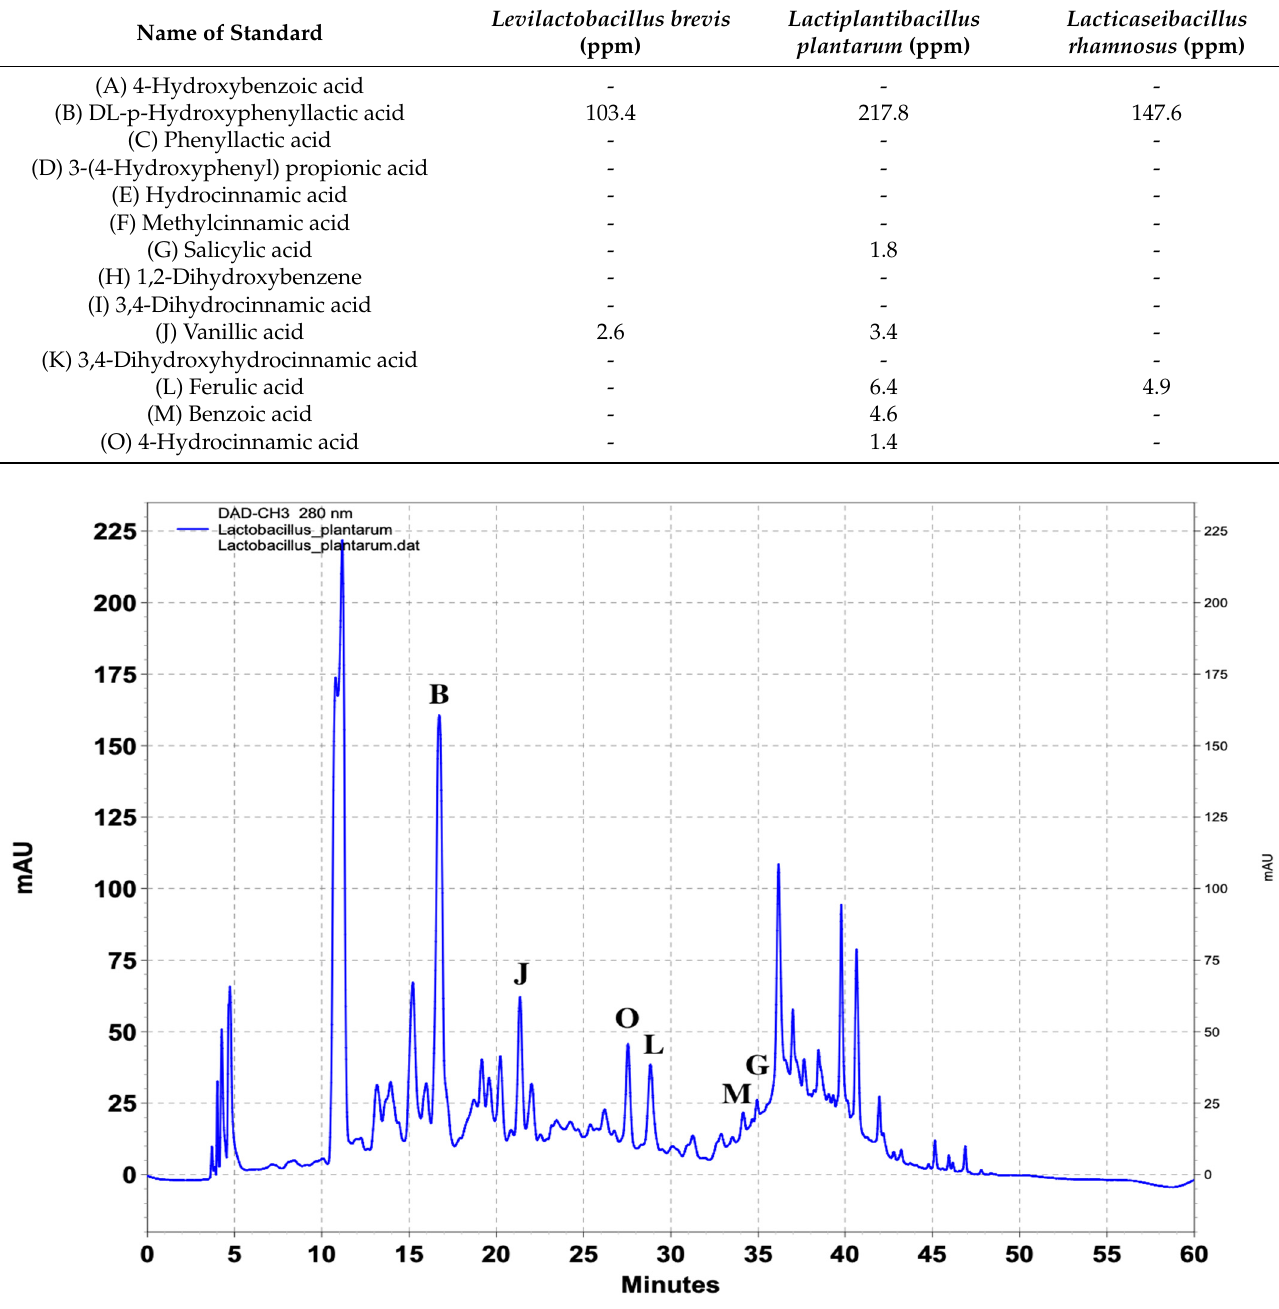
Figure 5. Chromatographic profile of Lactiplantibacillus plantarum ATCC14917 showing antimicrobial activity. High mass accuracy spectrum of compound (B) OH-PLA (16.3 min); high mass accuracy spectrum of compound (J) Vanillic acid (21.3 min); high mass accuracy spectrum of compound (O) 4-Hydrocinnamic acid (27.4 min); high mass accuracy spectrum of compound (L) Ferulic acid (28.7 min); high mass accuracy spectrum of compound (M) Benzoic acid (34.2 min); high mass accuracy spectrum of compound (G) Salicylic acid (36 min). Table 3. Concentration (in ppm) of metabolites produced by Levilactobacillus brevis, Lactiplantibacillus plantarum and Lacticaseibacillus rhamnosus.